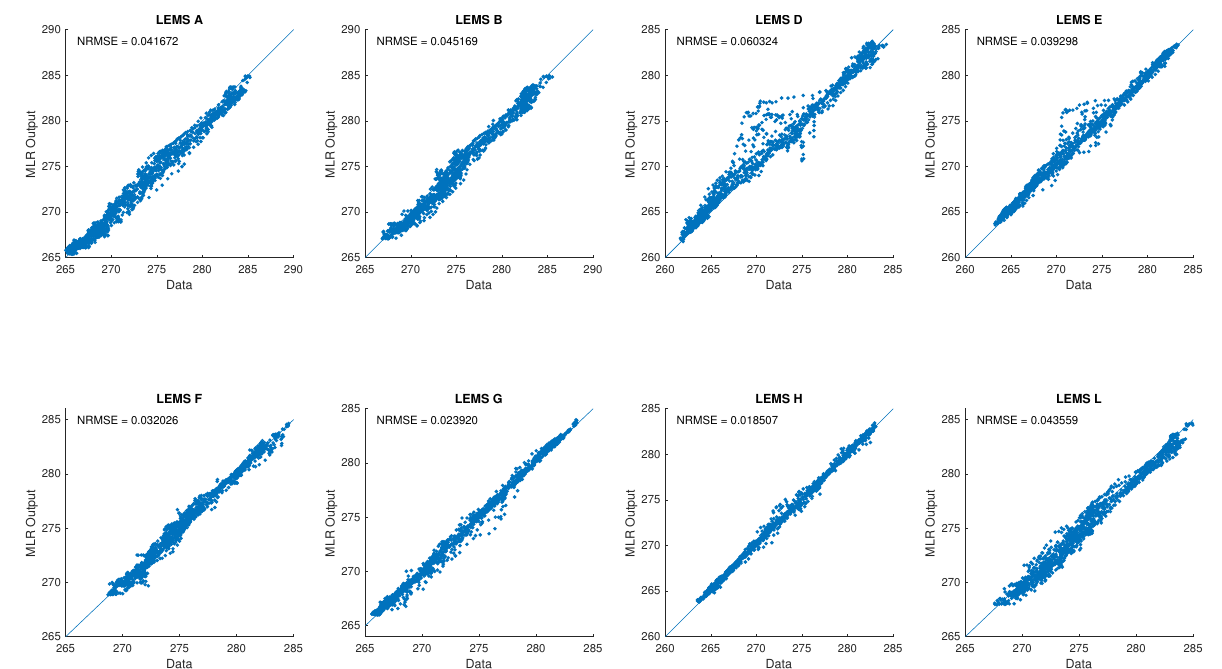
Figure A3. Scatter plots for the MLR prediction of virtual potential temperature for the 15